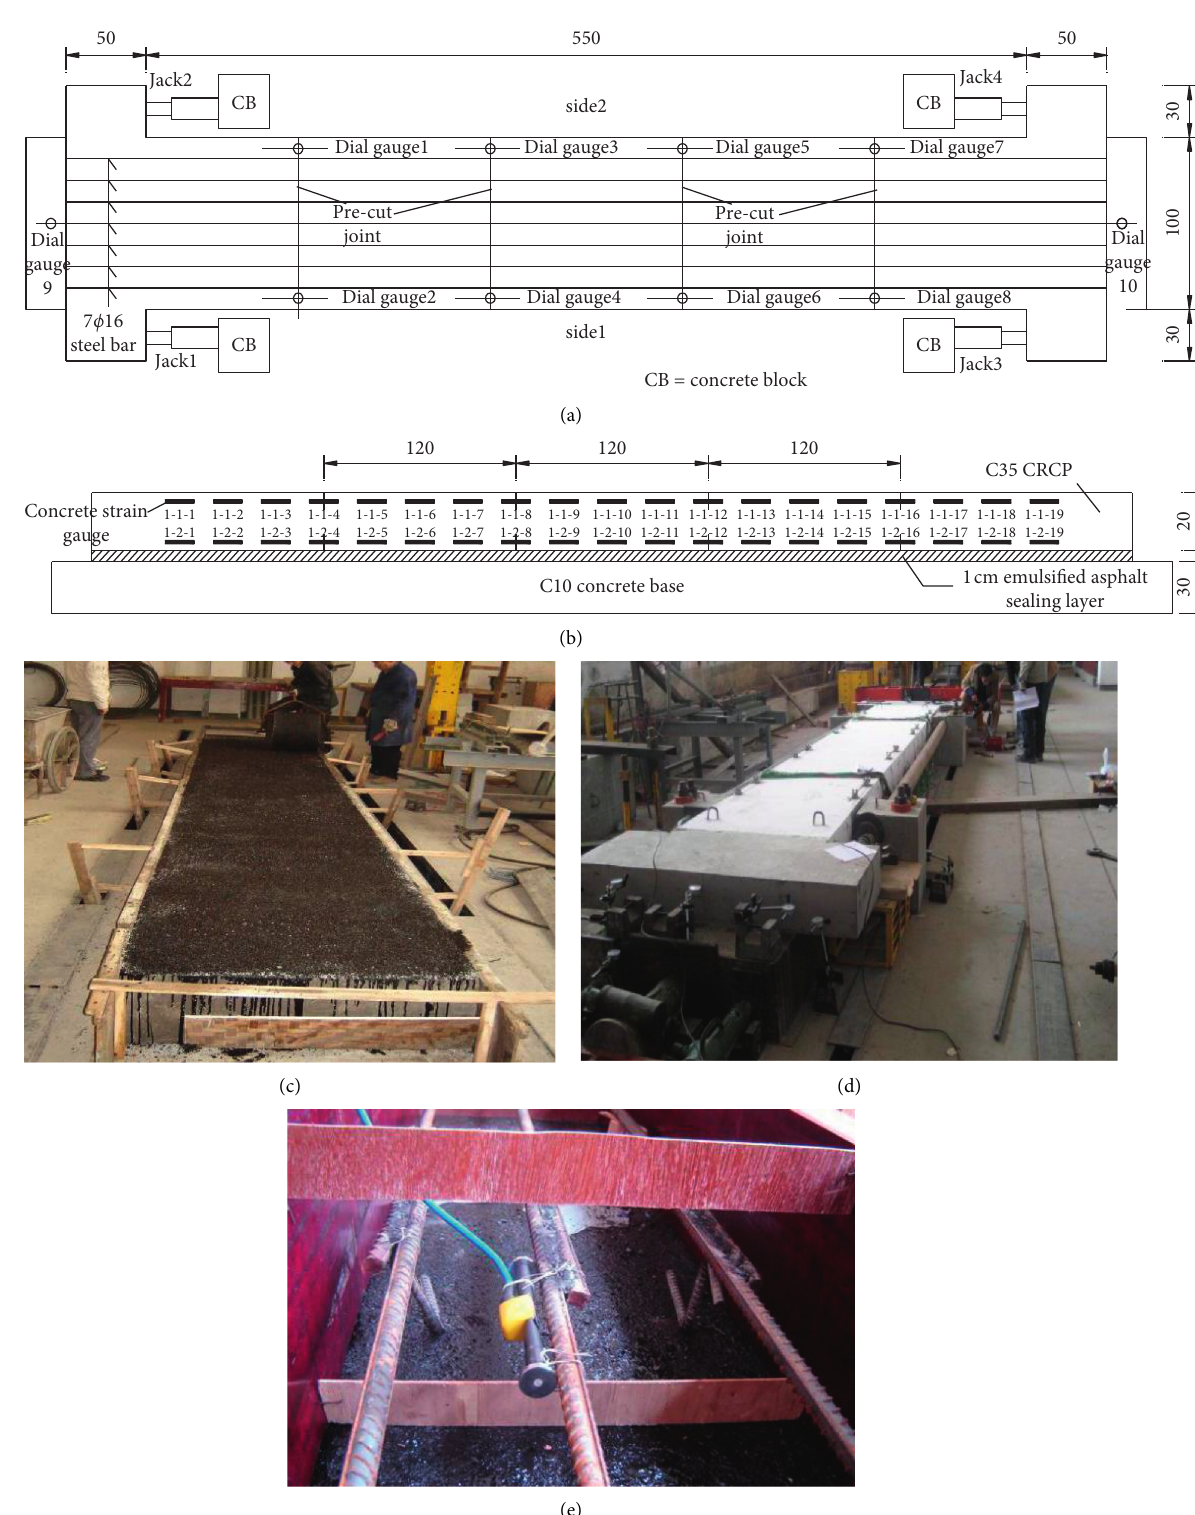
Figure 11: Illustration of the CRCP slab experimental model (unit: cm) [18]. (a) Plan. (b) Elevation. (c) Laying of the emulsified asphalt sealing layer. (d) Test model. (e) Plywood for precut